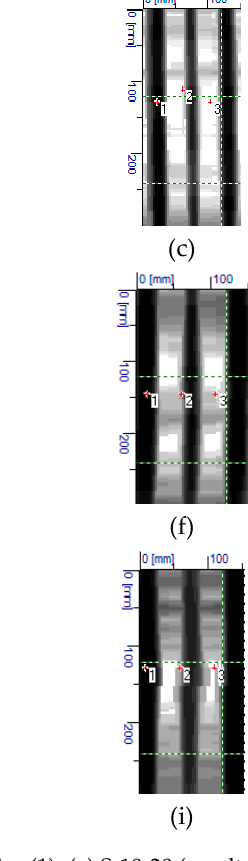
Figure 21. Results from tests conducted with the electromagnetic device (1): ( a ) S-10-20 (result: three rebars, ø obs = 6 mm, c obs = 11 mm), ( b ) S-10-30 (three rebars, ø obs = 12 mm, c obs = 12 mm), ( c ) S-10-40 (three rebars, ø obs = 10 mm, c obs = 11 mm), ( d ) S-16-20 (two rebars, ø obs = 30 mm, c obs = 32 mm), ( e ) S-16-30 (three rebars, ø obs = 16 mm, c obs = 27 mm), ( f ) S-16-40 (three rebars, ø obs = 16 mm, c obs = 24 mm), ( g ) S-20-20 (two rebars, ø obs = 20 mm, c obs = 48 mm), ( h ) S-20-30 (three rebars, ø obs = 20 mm, c obs = 47 mm), ( i ) S-20-40 (three rebars, ø obs = 20 mm, c obs = 35 mm)